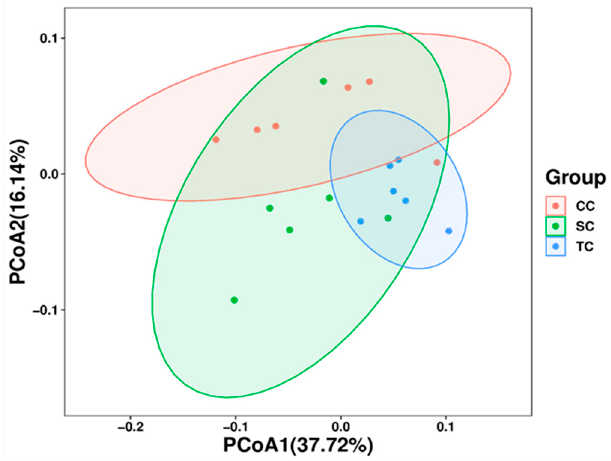
Figure 2. Beta diversity analysis of microbial communities using principal coordinate analysis (PCoA) based on weighted UniFrac distances. CC, control group; SC, 25% of soybean meal (SBM) replaced with fermented SBM (FSBM); TC, 50% of soybean meal (SBM) replaced with fermented SBM (FSBM).